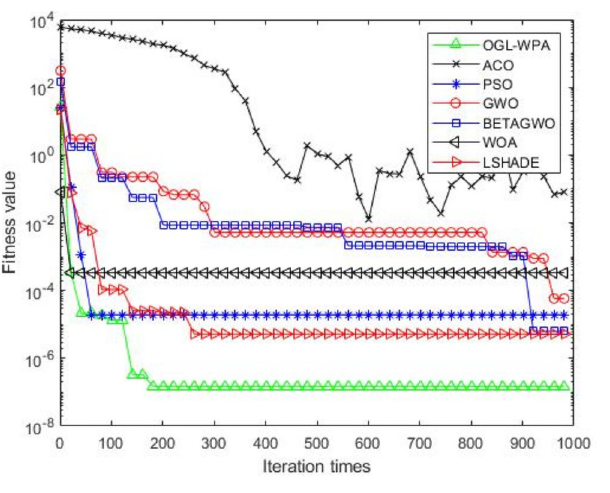
Fig 2. F1 iteration curve.